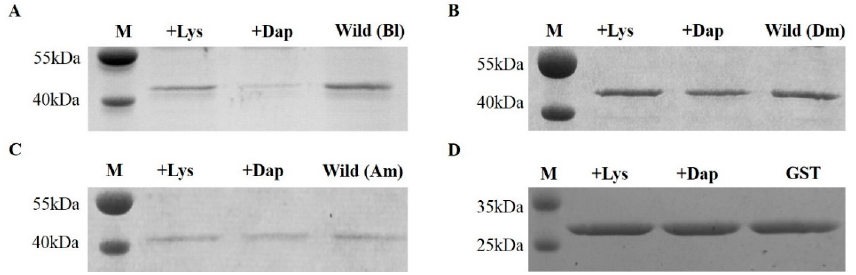
Figure 2. Analysis of the peptidoglycan (PGN)-binding ability of the wild-type bumblebee Bombus lantschouensis PGRP-LC (Bl-PGRP-LC) and honeybee Apis mellifera PGRP-LC (Am-PGRP-LC). Each sample includes four lanes. The first lane (M) is the marker; the second lane (+Lys) shows the corresponding protein samples after pull-down with the meso-diaminopimelic acid (Dap-type) PGN from B. subtilis ; the third lane (+Dap) shows the corresponding protein samples after pull-down with the L-lysine type (Lys-type) PGN from M. luteus ; and the fourth lane shows the normal corresponding protein as a control. ( A ) Analysis of the PGN-binding ability of the wild-type Bl-PGRP-LC. ( B ) The analysis of the PGN-binding ability of the wild-type Dm-PGRP-LC. ( C ) Analysis of the PGN-binding ability of the wild-type Am-PGRP-LC. ( D ) Analysis of the PGN-binding ability of the GST-tagged protein.